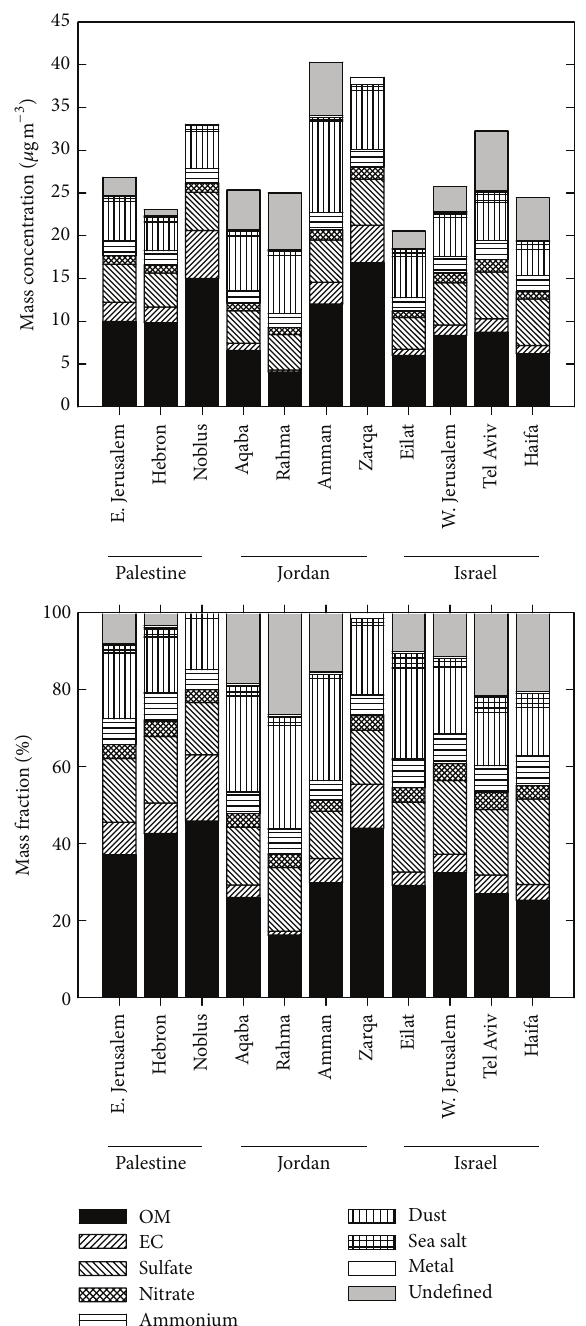
Figure 7: Annual average mass concentration (top) and mass fraction(bottom)ofmajorPM 2.5